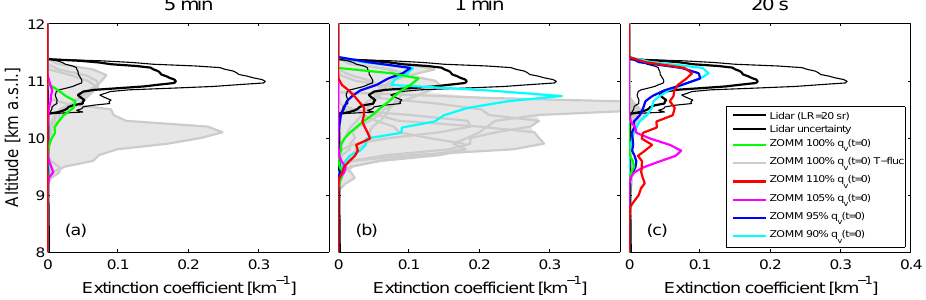
Figure 8. Extinction profiles above Jungfraujoch at 09:00UTC on 22 November 2011 calculated by ZOMM along offline trajectories with a temporal resolution of 5min (a) and 1min (b) , and along online trajectories with a temporal resolution of 20s (c) . All simulations assume homogeneous nucleation only. Thick black line: measured lidar profile. Thin black lines: measurement uncertainty, i.e. uncertainties in the lidar signal, the assumption of lidar ratio and the molecular properties retrieved from COSMO-2 analysis data. Different colours: calculated profiles for simulations with modified initial specific humidities q v (t = 0 ) of the trajectories. Grey lines: simulations of the reference run (100% q v (t = 0 ) ) with 20 different sets of superimposed small-scale temperature fluctuations.